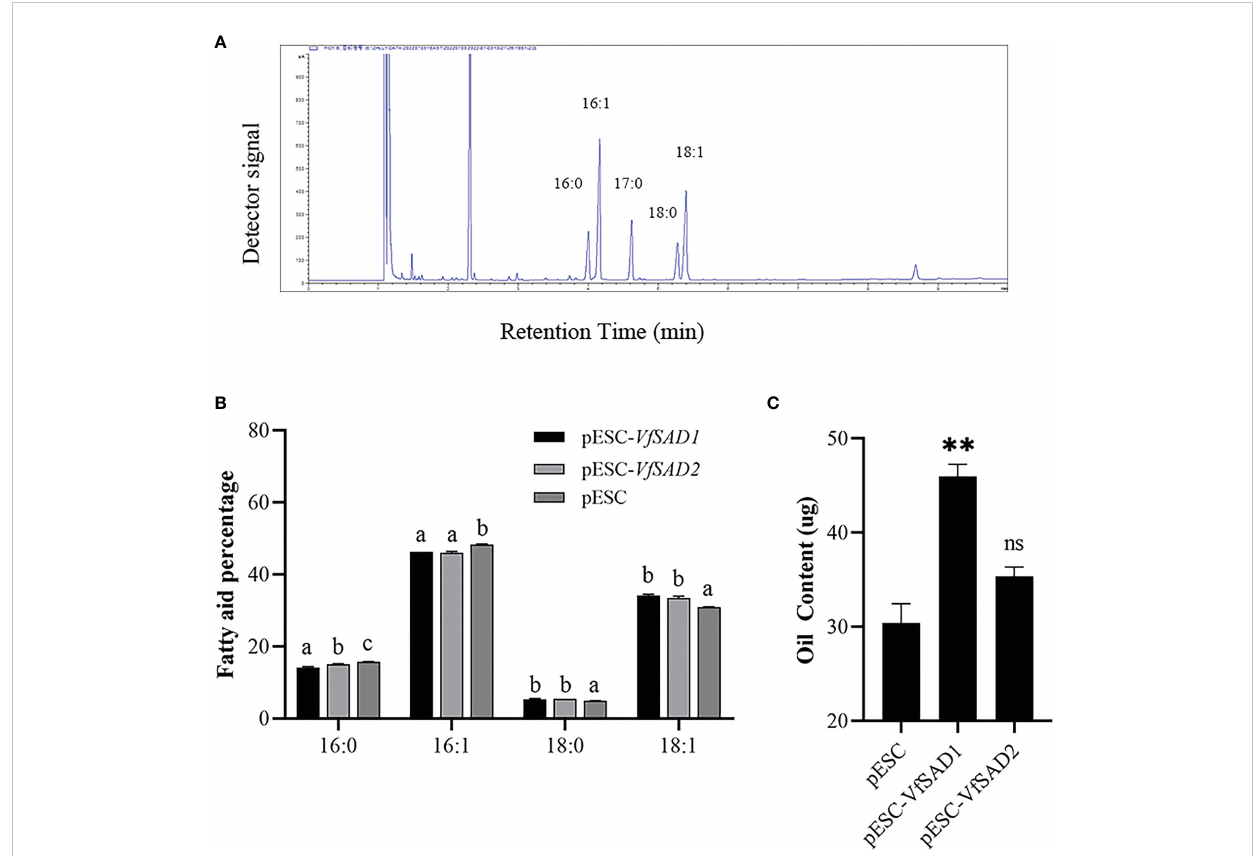
FIGURE 3 The VfSAD1/2 improves oil content and alters the percentage of the fatty acid component in the S. cerevisiae BY4741. (A) GC-FID analysis of fatty acid methyl esters derived from neutral lipids isolated from S. cerevisiae BY4741. (B) The percentage of fatty acid components in the wild-type BY4741 containing the empty plastid and transgenic BY4741 with the overexpression of VfSAD1 or VfSAD2 . (C) Oil content in the wild-type BY4741 and transgenic BY4741 containing VfSAD1 or VfSAD2 . The error bar represents the standard deviation (± SD) for setting three biological replicates. Signi fi cant difference was detected by t -test (* indicates p < 0.05; ** indicates p < 0.01). A comparison between groups was conducted by one-way ANOVA test (FA component), and the different letters above the bar chart indicate signi fi cant differences (p<